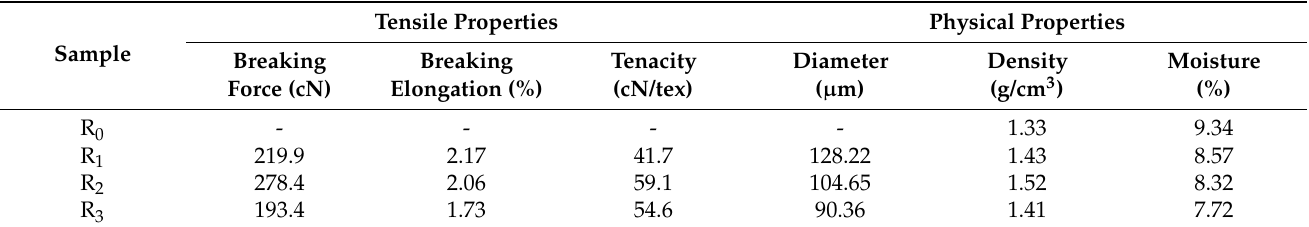
Table 3. Summary of the mean values of tensile and physical properties of fibers.